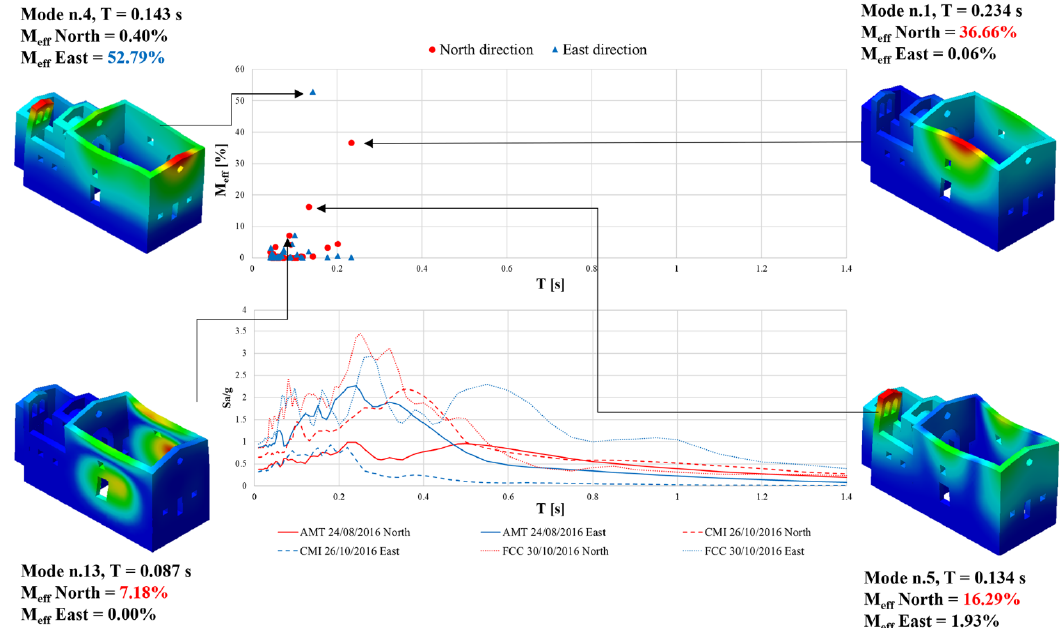
Figure 9. Distribution of modal shapes in the longitudinal and transversal directions and comparison with the pseudo- acceleration response spectra of the three main shocks of Central Italy seismic sequence of 2016 for Madonna of Valcora Sanctuary in Fiuminata (Macerata, Central Italy).